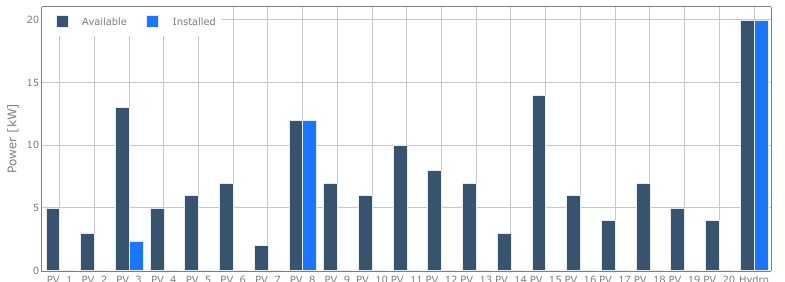
Figure 10. Optimal installed power for each generator’s availability.